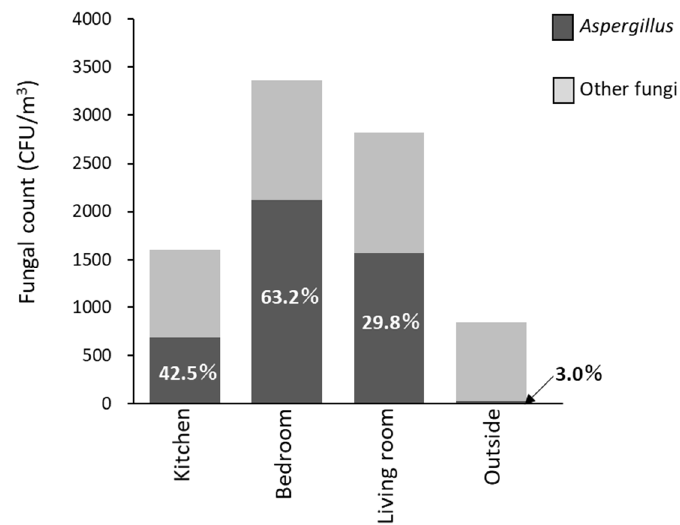
Figure 7. Ratio of Aspergillus in fungal count in the indoor-air of temporary houses during the autumn and winter months. We collected samples in 17 temporary houses from October 2014 to March 2015. Bar-plots represent fungal counts on DG-18 agar plates.